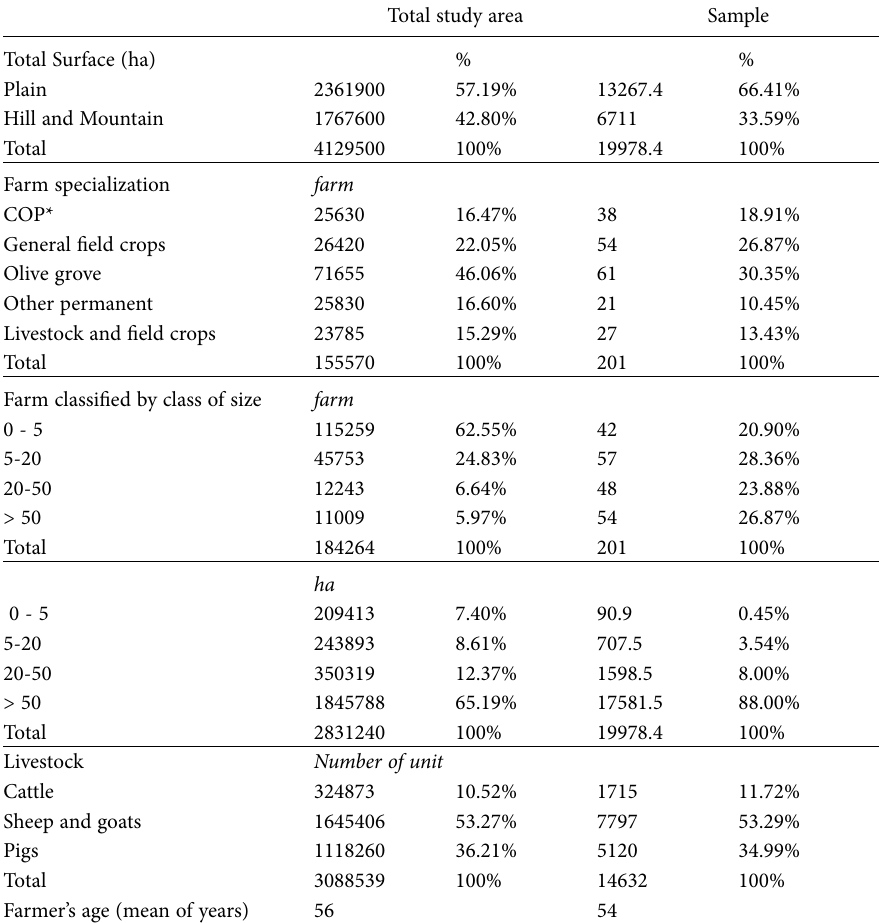
Table 1. Comparison between area study and sample Total study area